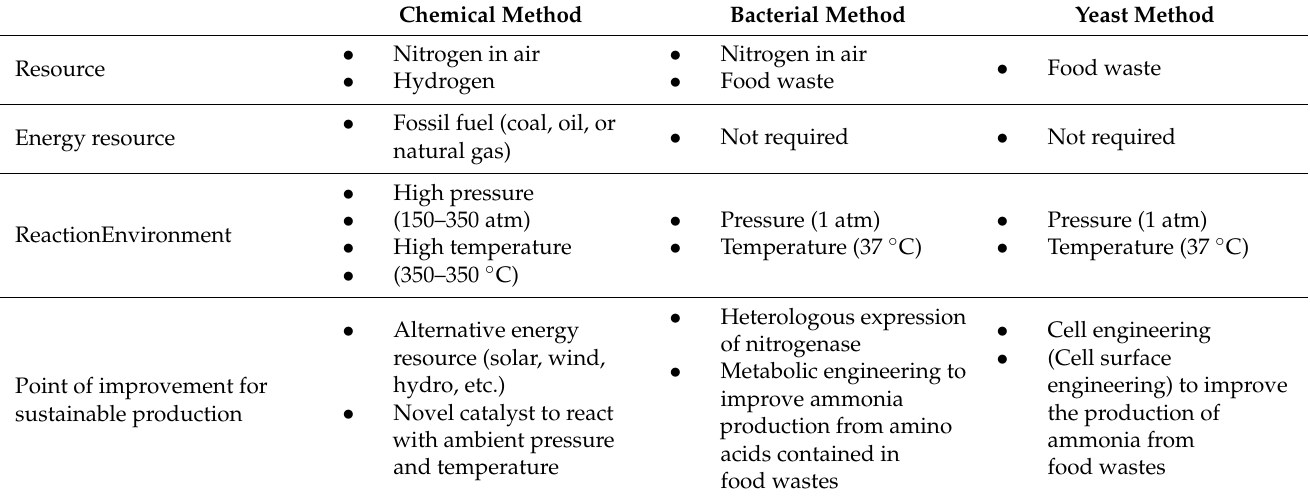
Table 2. Summary of ammonia production